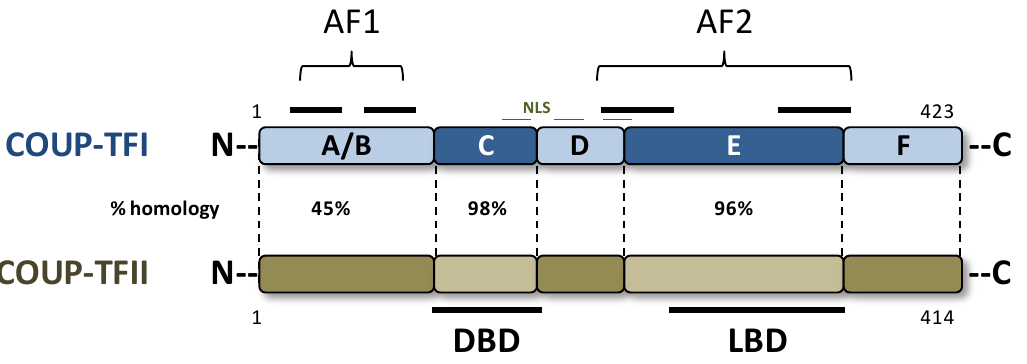
Figure 1. Schematic structure of human COUP-TFI and COUP-TFII proteins. The different domains are represented with the percentage of amino acid identity between the two receptors. The N-terminal and C-terminal transactivation functional domains (AF-1, AF-2); as well as DNA-binding domain (DBD); nuclear localization signal (NLS); and putative ligand-binding domain (LBD) are